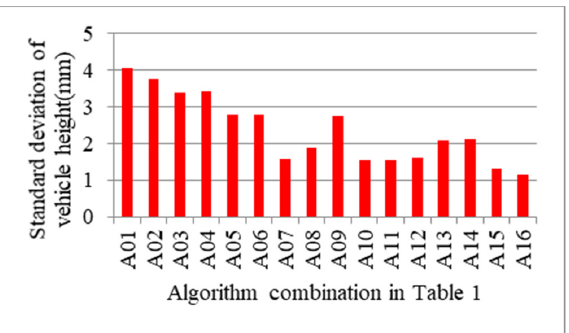
Figure 15. Standard deviation of vehicle width according to algorithm combination in Table 1.